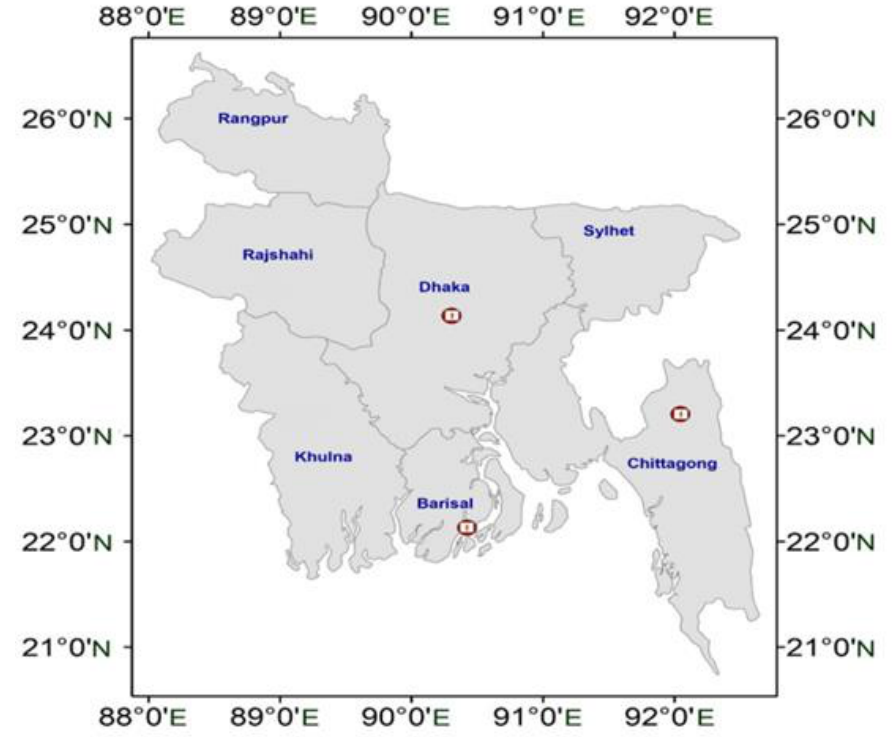
Figure 1: Map showing the different sampling locations of Bangladesh. Map was prepared based on the coordinate of location using ArcGIS